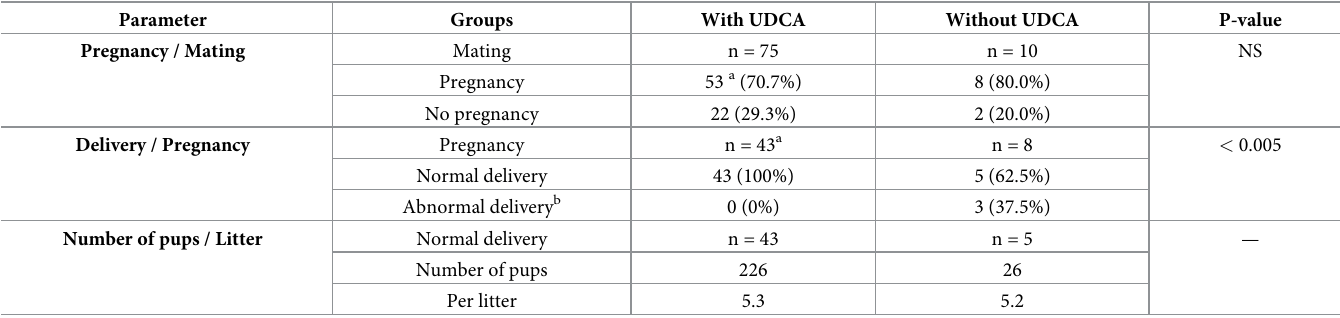
Table 1. Effects of UDCA administration on the fertility of DKO